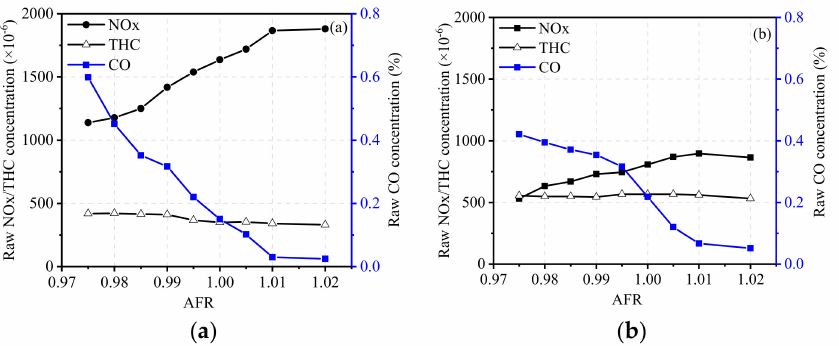
Figure 5. Raw emissions of the engine under the conditions of ( a ) 2100 N · m at 1300 r / min and ( b ) 1700 N · m at 1800 r /